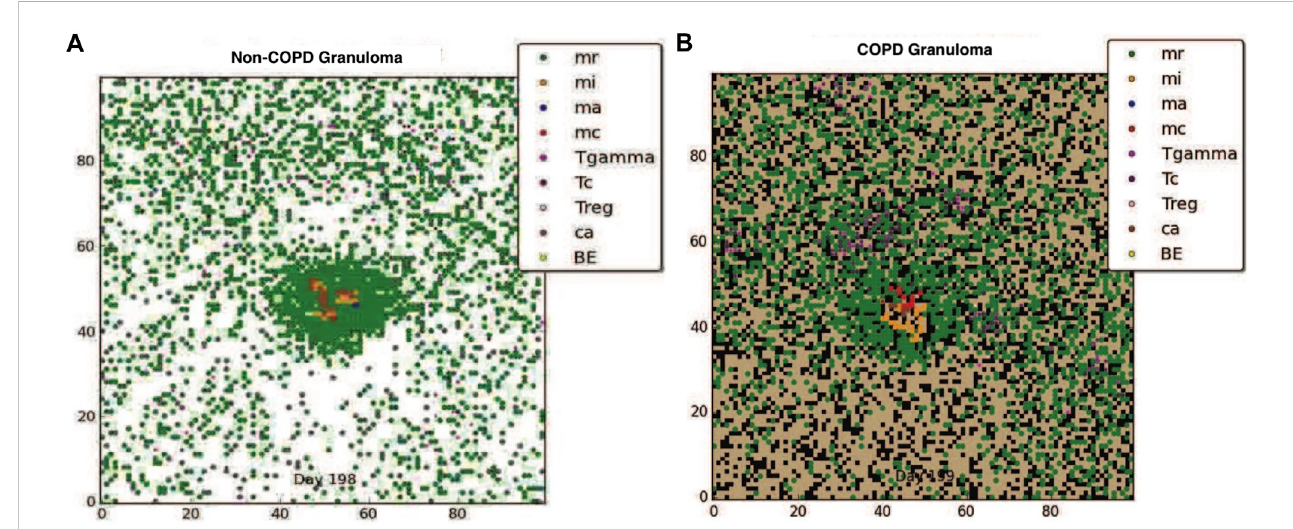
FIGURE 1 (A) The containment granuloma for the non-COPD individual. (B) The containment granuloma for an individual with COPD. Black region represents emphysematous tissue. Abbreviations: infected macrophage (mi), activated macrophage (ma), resting macrophage (mr), chronically infected macrophage (mc), T- γ cells (Tgamma), cytotoxic T cells (Tc), regulatory T cells (Treg), caseous tissue grid cells (ca), extracellular bacteria (BE) (Segovia-Juarez et al., 2004; Ray et al., 2009; Sershen et al.,